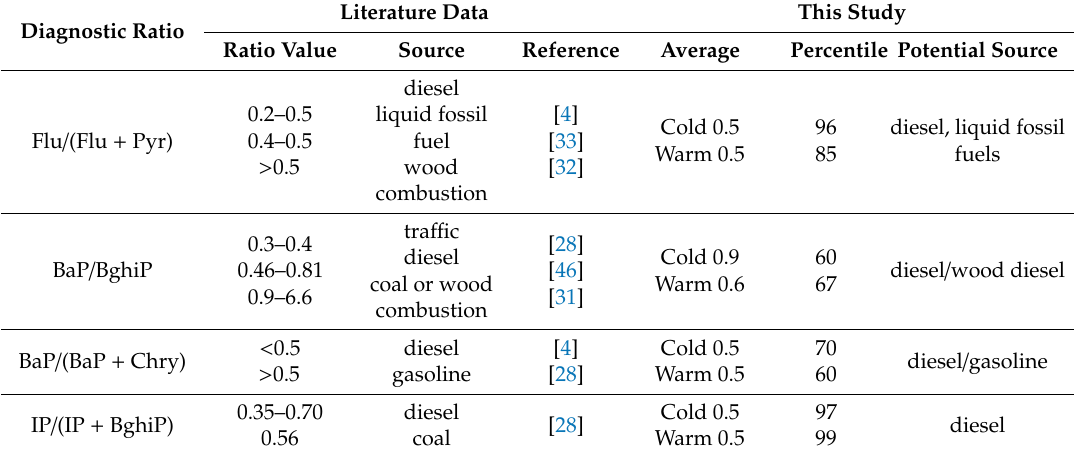
Table 3. Comparison of PAH average diagnostic ratios in PM 1 during cold and warm period and the main emission